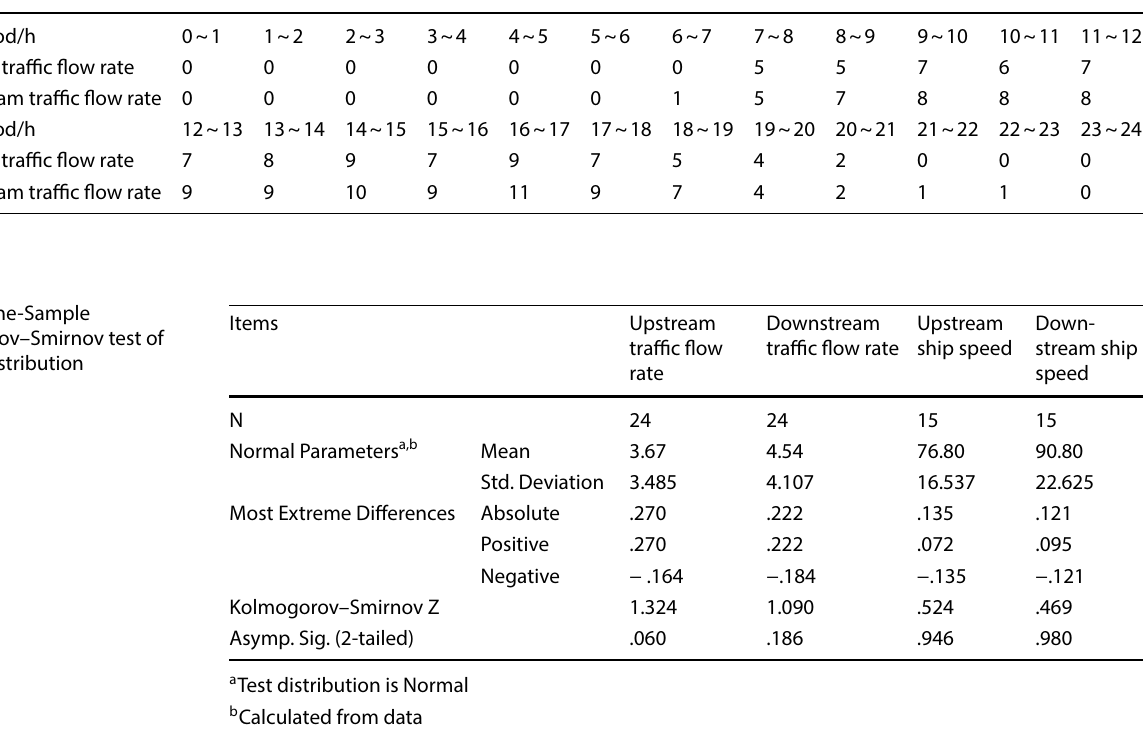
Table 4 One-Sample Kolmogorov–Smirnov test of Poisson